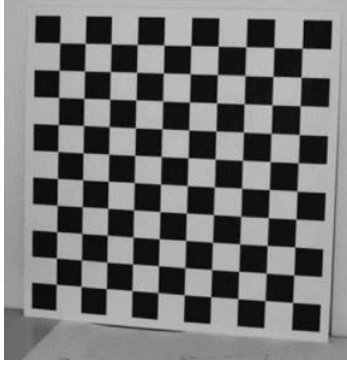
Fig. 3. Test field of camera calibration